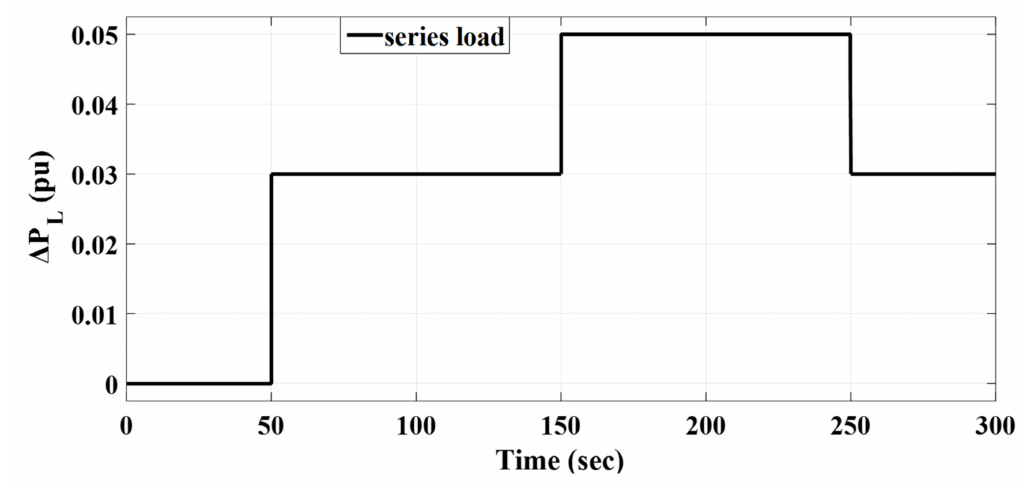
Figure 21. The form of the applied series SLP.